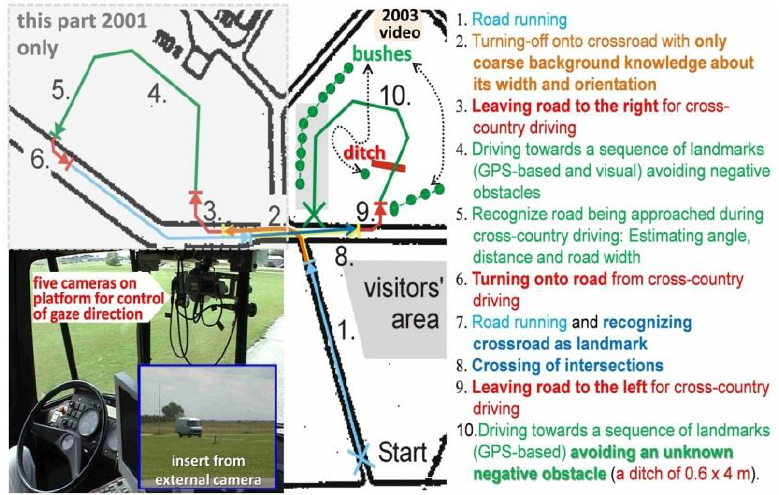
Figure 8. Final demo of project AutoNav: Mission performance ‘On- and Off-Road’ with active (including saccadic) gaze control for turn-offs left and right; detect and avoid negative obstacles.